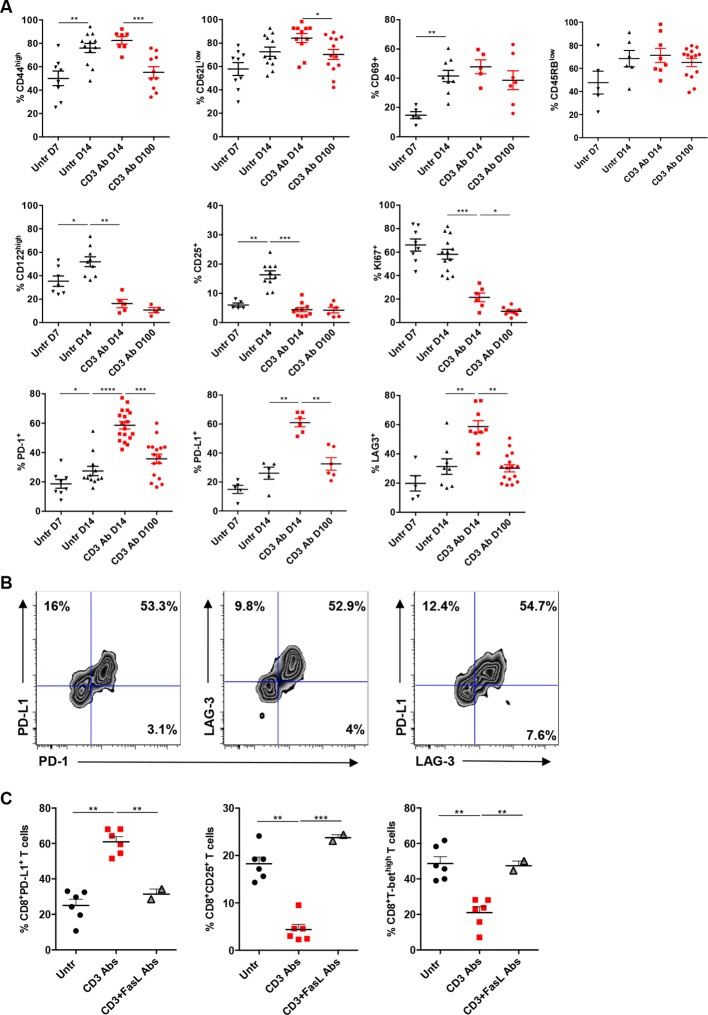
Phenotypic and functional characteristics of tolerant CD8+ T cells.Pancreatic islet allografts were recovered from C57BL/6 mice after CD3 Ab treatment administered at day +7 post-transplant. (A) Expression of CD44, CD62, CD69, CD45RB, CD122, Ki67, CD25, PD-1, PD-L1 and LAG-3 (6–16/group) was evaluated on CD8+ T cells on day +7, day +14 and day +100 post-transplant (*p<0.05, **p<0.01, ***p<0.001). (B) Co-expression of PD-1/PDL-1, PD-1/LAG-3 and PD-L1/LAG-3 on graft-infiltrating CD8+ T cells recovered from CD3 Ab-treated mice on day +14 post-transplant. (C) Expression of PD-L1, CD25 and T-bet by graft infiltrating CD8+ T cells isolated on day14 from untreated, CD3 Abs or CD3FasL Abs-treated recipients (n = 2–6/group) (**p<0.005).